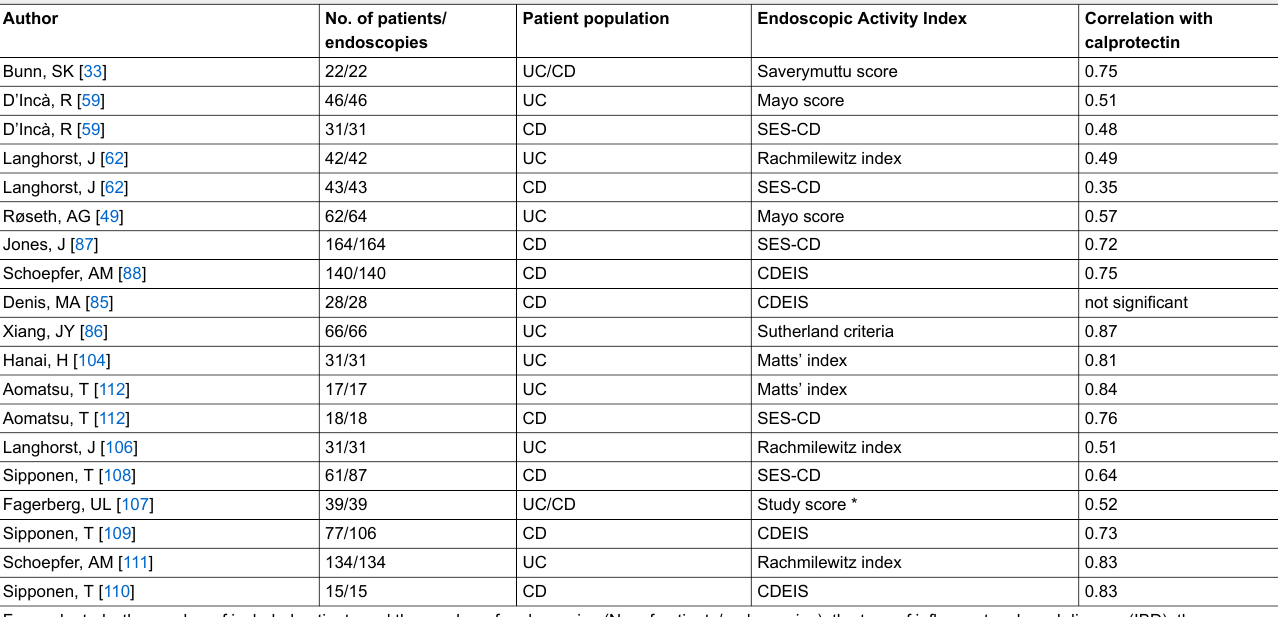
Table 3: Studies investigating the correlation between faecal calprotectin levels and endoscopic IBD activity.